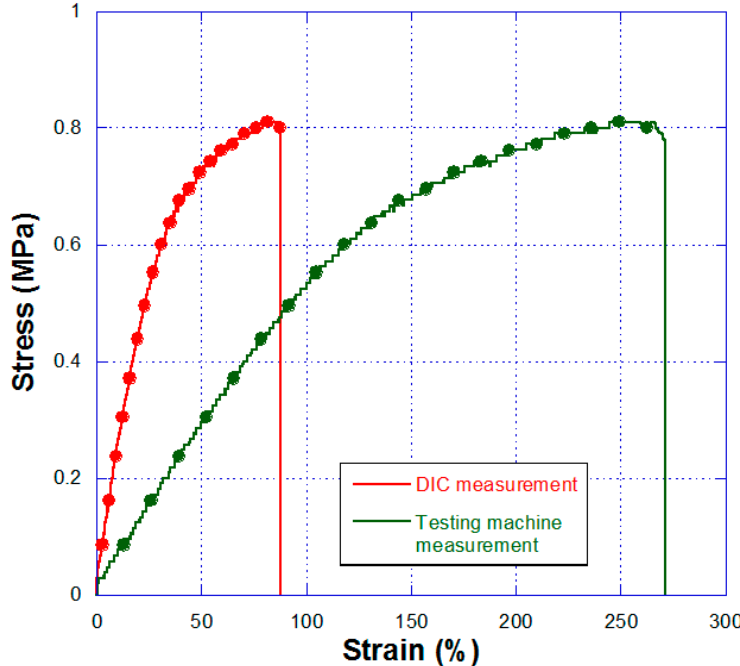
Figure 14. Tensile test results of the nanofiber mat specimen for DIC and testing machine measurements (red and green dots: measurement points by 20 s).